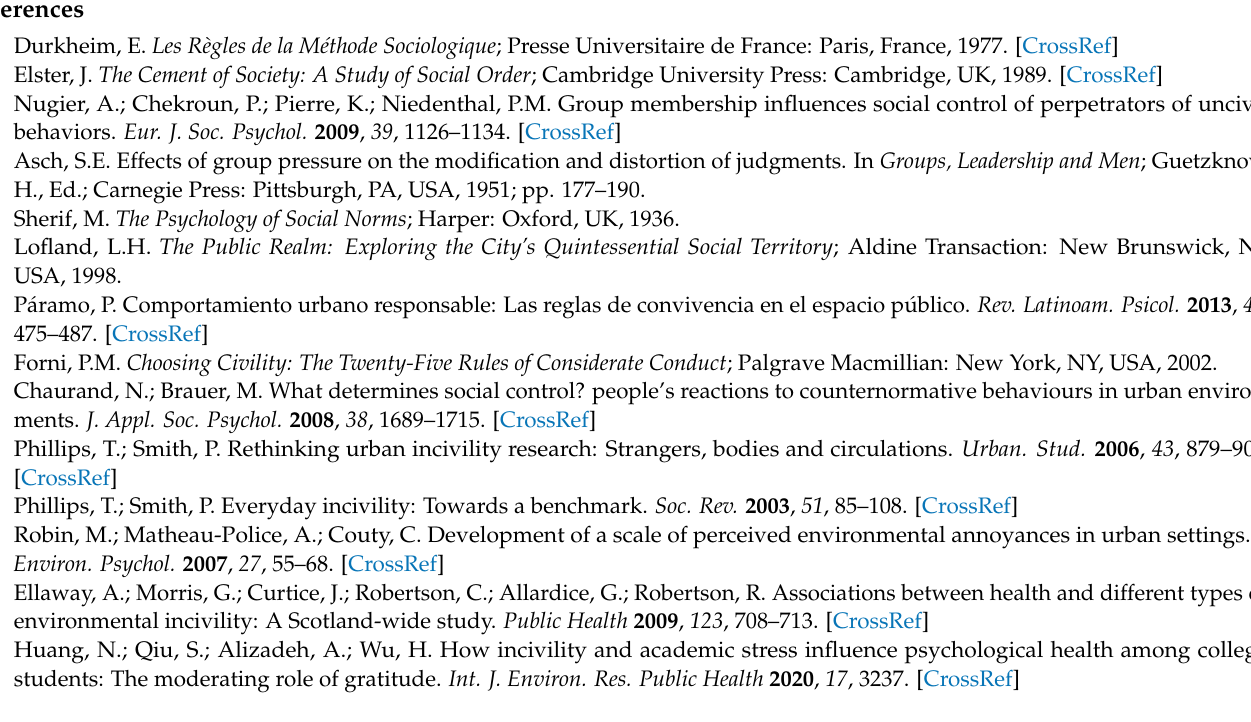
Figure A6. Uncivil pictures.